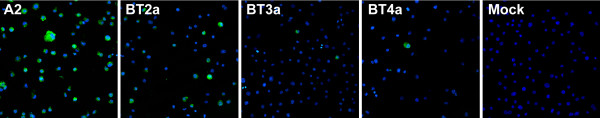
Differential infectivity between RSV A2, BT2a, BT3a and BT4a. PBECs were infected with RSV A2, BT2a, BT3a and BT4a (MOI of 0.1) during 2 h and washed with PBS. Seventy two hpi, cells were washed with PBS, fixed with 4% paraformaldehyde and stained for RSV F protein (green) and nuclei (blue). Cultures were observed under a confocal microscope. RSV A2 infected considerably more PBECs than the 3 clinical isolates. Original magnification, x10.